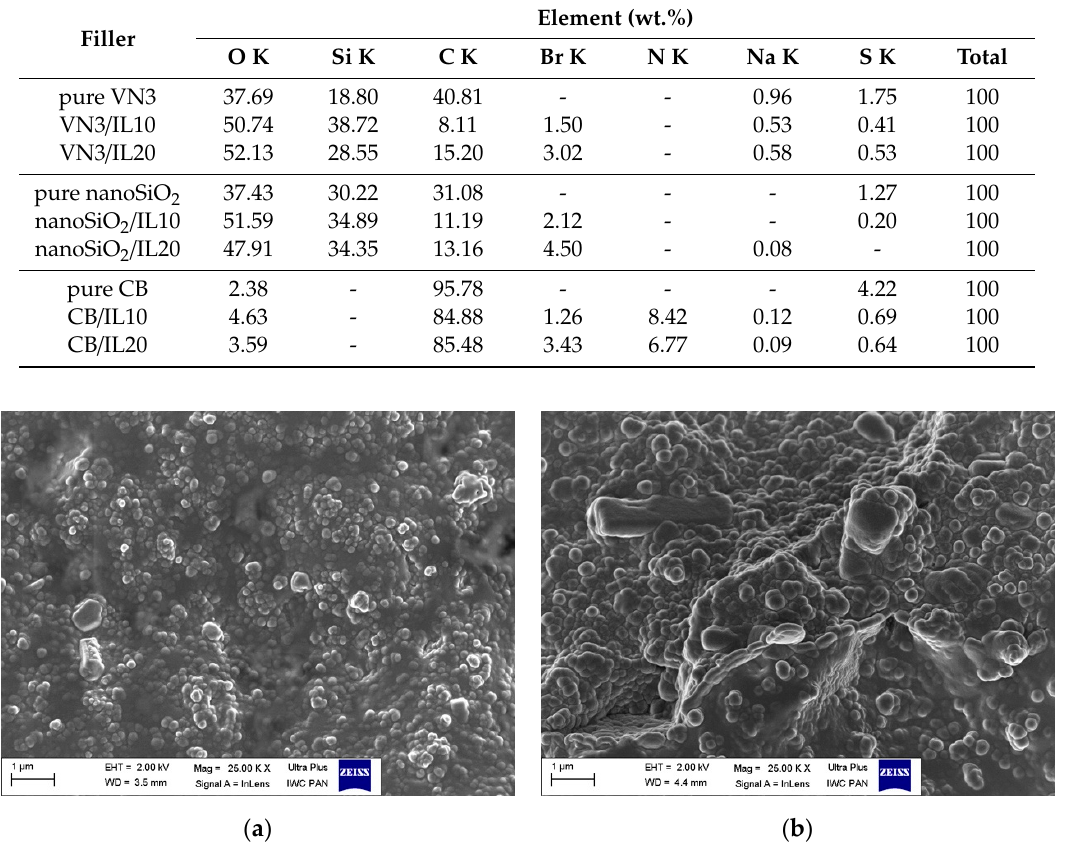
Table 7. Energy-dispersive X-ray spectroscopy (EDS) analysis of pure and DmiBr-modified fillers.